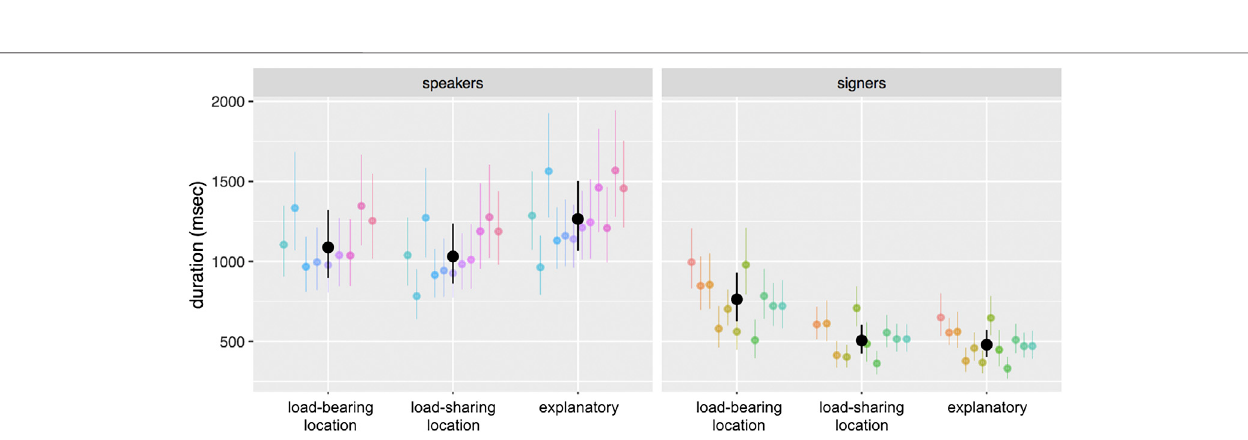
FIGURE 4 | Results from the model predicting the duration of a point as a function of participant group and semantic function. Speakers ’ points were longer in durationoverallthansigners ’ points,andwerelongerwhenpartofexplanatoryutterances.Incontrast,signers ’ load-bearinglocationpointswerelongerthaneitherofthe othertwotypes.Blackdotsrepresentgroupmeans,andblacklinesrepresent95%con fi denceintervalsaroundthosemeans;coloreddotsandlinesrepresentindividual